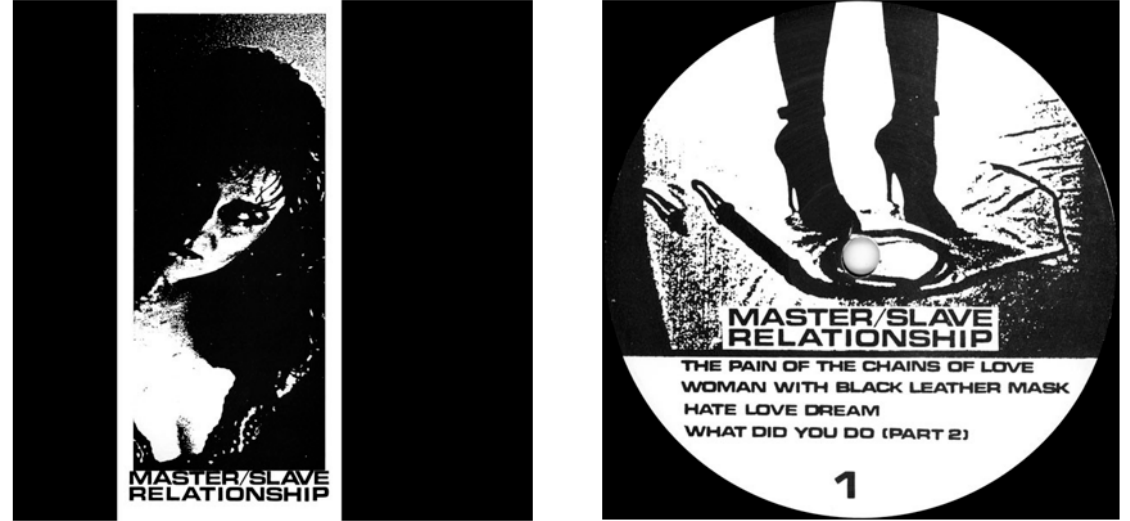
Figure 6. Master/Slave Relationship, This Lubricious Love , RRRecords, 1987, vinyl, LP. For Debbie Jaffe, S&M practices became another tool in the fight against all forms